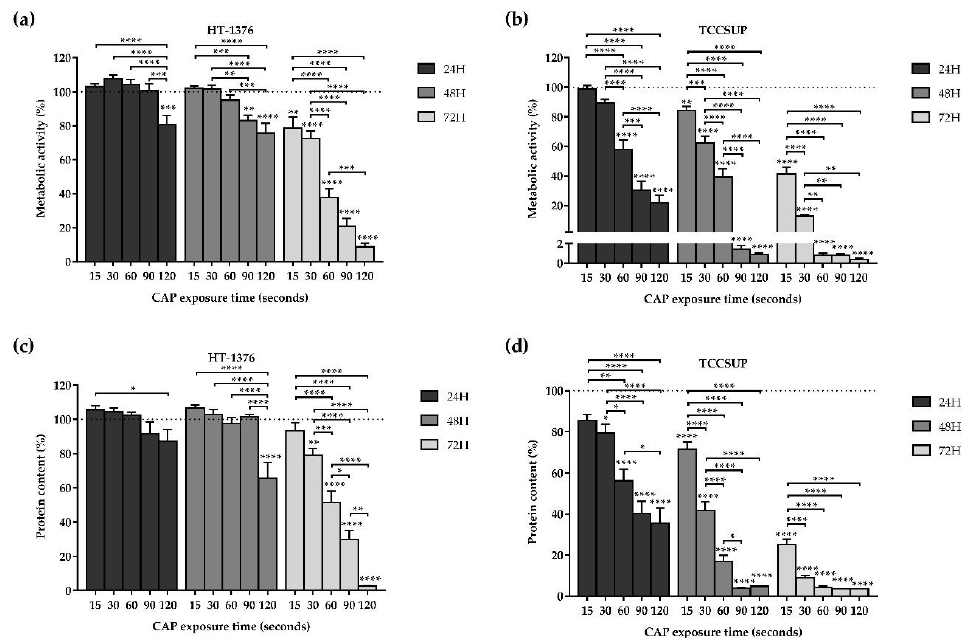
Figure 1. CAP decreases cell metabolic activity and protein content of the HT-1376 ( a , c ) and TCCSUP ( b , d ) cell lines in an exposure time- and time after CAP treatment-dependent manner. Metabolic activity and protein content were evaluated using MTT and SRB assays, respectively, 24, 48, and 72 h after CAP treatment. Results are expressed as the mean ± SEM of the percentage of metabolic activity or protein content normalized to control (n = 6 independent experiments in triplicate). Statistical differences between exposure times within 24 or 48 or 72 h after the CAP treatment are represented with “*” with horizontal bars and the differences between the exposure times and the control within 24 or 48 or 72 h after the CAP treatment are represented with “*” on top of the respective column, being p value reported as * p ≤ 0.05, ** p ≤ 0.01, *** p ≤ 0.001, **** p ≤ 0.0001.